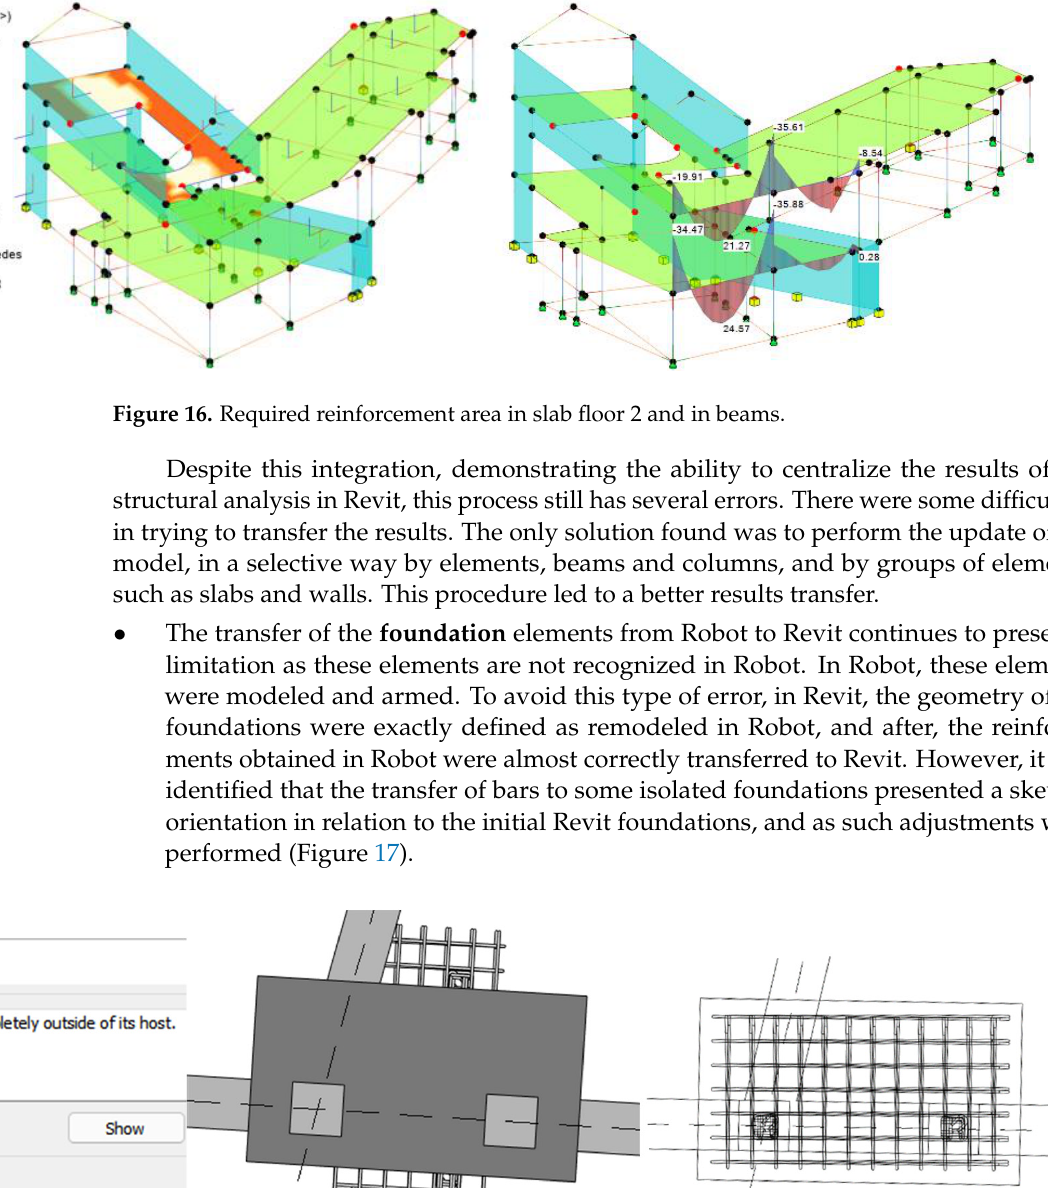
Structural Wall (Support)